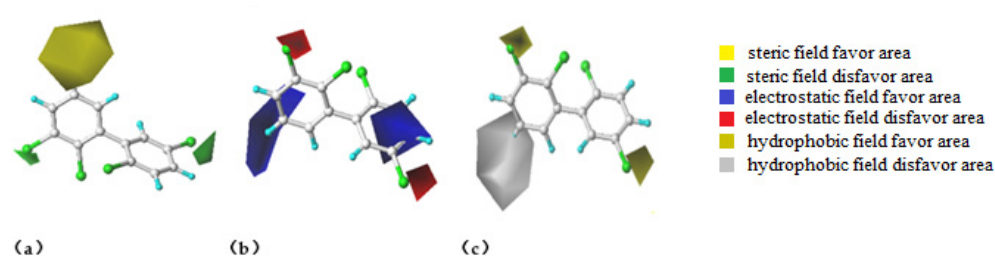
Figure 2. A 3D contour map of the CoMSIA steric field ( a ), electrostatic field ( b ), and hydrophobic field ( c ) of PCB-44.